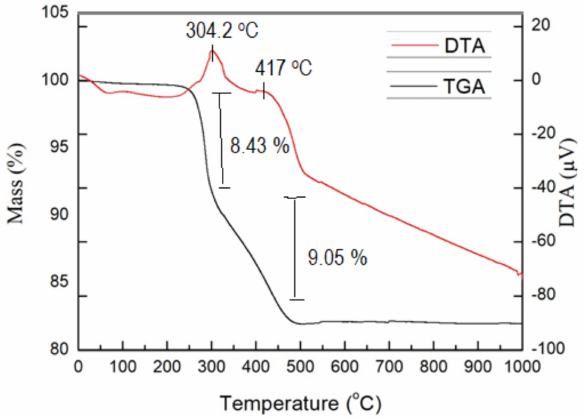
Figure 2. DTA–TGA curve of